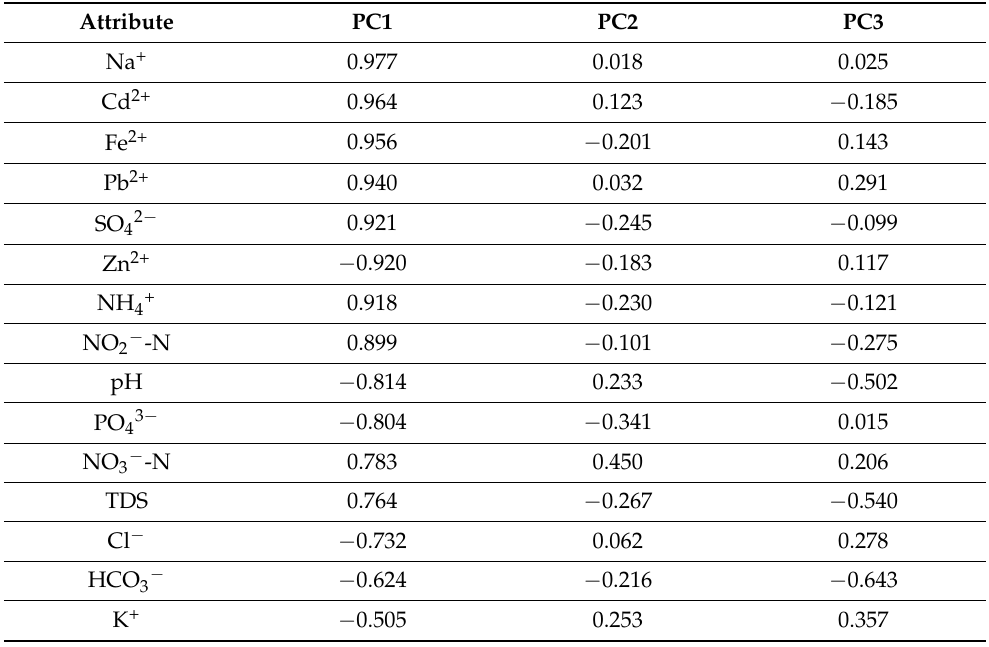
Table 3. Principal components of the physicochemical parameters.